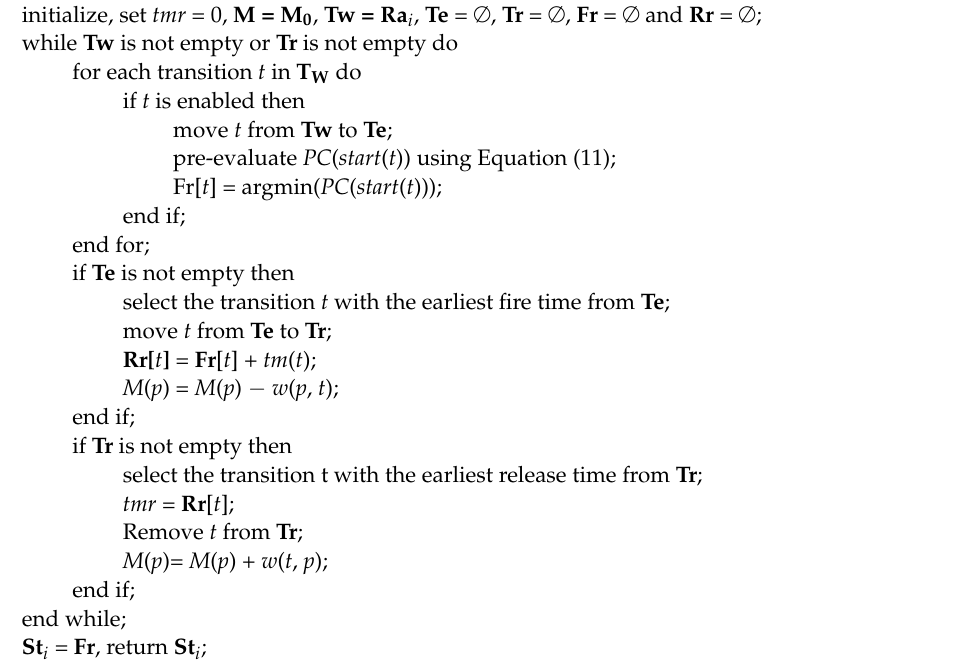
Algorithm 1 The procedure of the PN simulation